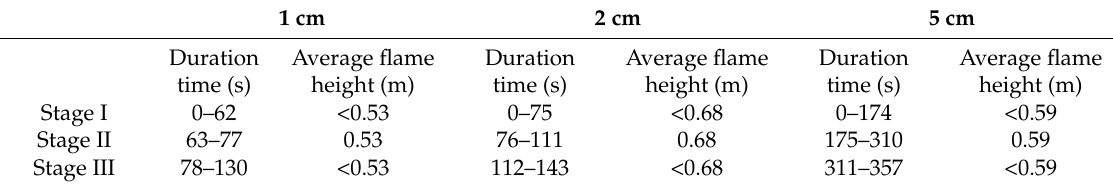
Table 1. The duration of the three stages and the average flame height for the three thickness